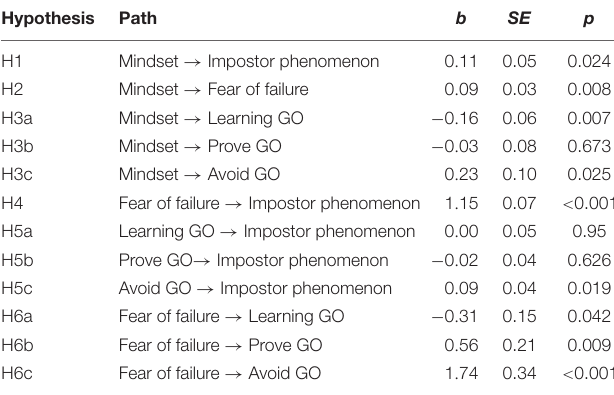
TABLE 3 | Unstandardized coefficients of the simple relationships between variables. Hypothesis Path